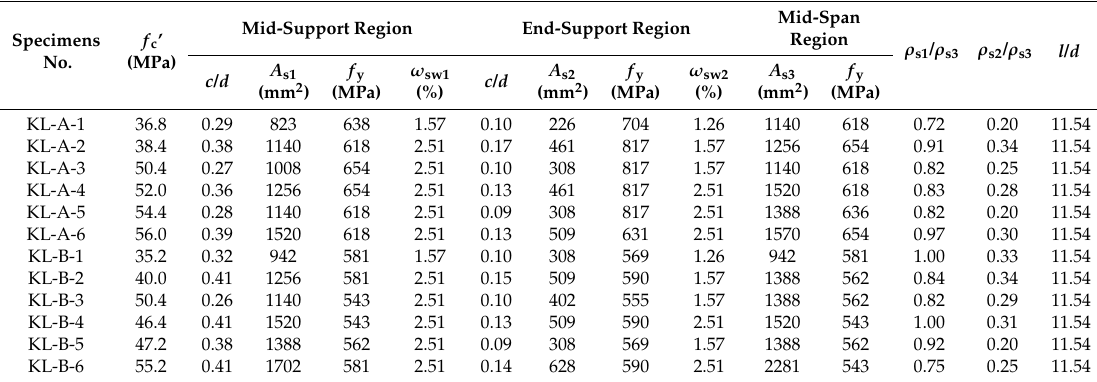
Table 3. Details of 12 frame beams.